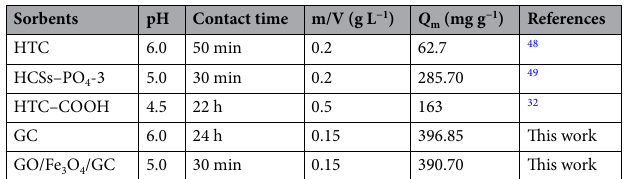
Table 2. Comparison of Q m of GO/Fe 3 O 4 /GC with reported other glucose-based sorbents for U(VI) adsorption.